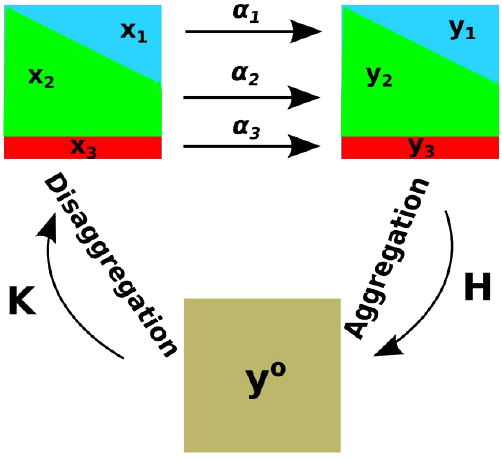
Fig. 1. The multi-patch data assimilation design for a grid cell split into three patches p each having their variables x p . The predicted observations y p are weighted with their fraction denoted by α p , where p ∈ 1, 2, 3. y o represents the grid-scale observation. The ob- servation operator H aggregates the predicted observations at the grid scale (Eq. 4). The data information is distributed among the patches via the Kalman gain K (Eq.